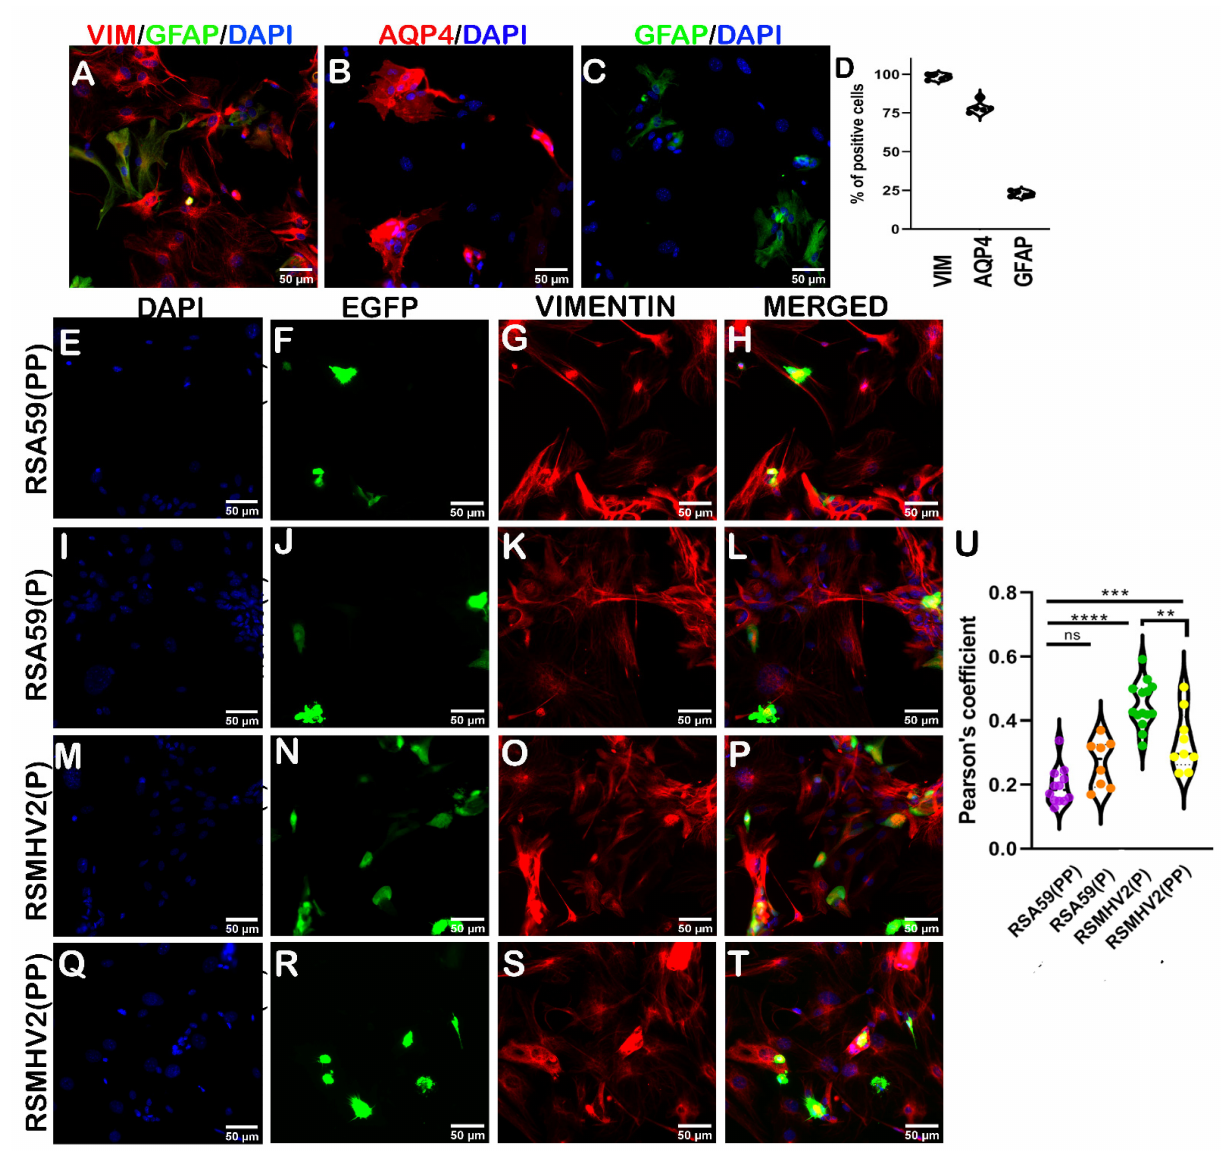
Figure 10. Characterization and infection of primary meningeal fibroblast cell cultures with two proline containing strains RSA59(PP), RSMHV2(PP), and single proline containing strains RSA59(P), and RSMHV2(P). Primary meningeal fibroblast cells enriched from meninges harvested from day 0–1 C57BL/6 pups were immunofluorescently characterized by double labeling with anti-vimentin (red; fibroblast marker) and anti-GFAP (green; astrocyte marker) ( A ), anti-aquaporin4 (red; matured fibroblast) ( B ), and anti-GFAP (green; astrocyte) ( C ). Cells were counterstained with DAPI. The data of the percentage of cells stained positive for the three markers were plotted ( D ). Primary meningeal fibroblast cell cultures were infected with RSA59(PP) ( E – H ), RSA59(P) ( I – L ), RSMHV2(P) ( M – P ), and RSMHV2(PP) ( Q – T ) at MOI 2. After 24 h p.i., cells were fixed and immunofluorescently labeled with vimentin and counterstained with DAPI. Representative images show infected cells in the EGFP panels ( F , J , N , R ) and vimentin-positive cells in the panels ( G , K , O , S ). Merged panels show colocalized EGFP and vimentin-stained cells. Quantification of the percentage of double-positive EGFP and vimentin cells is presented in a violin diagram ( U ). Experiments were performed three times in triplicate per strain (N = 9). The level of significance was taken at p < 0.05 following One-way ANOVA analysis. ** p < 0.001, *** p < 0.0001, **** p < 0.00001, and ns denotes